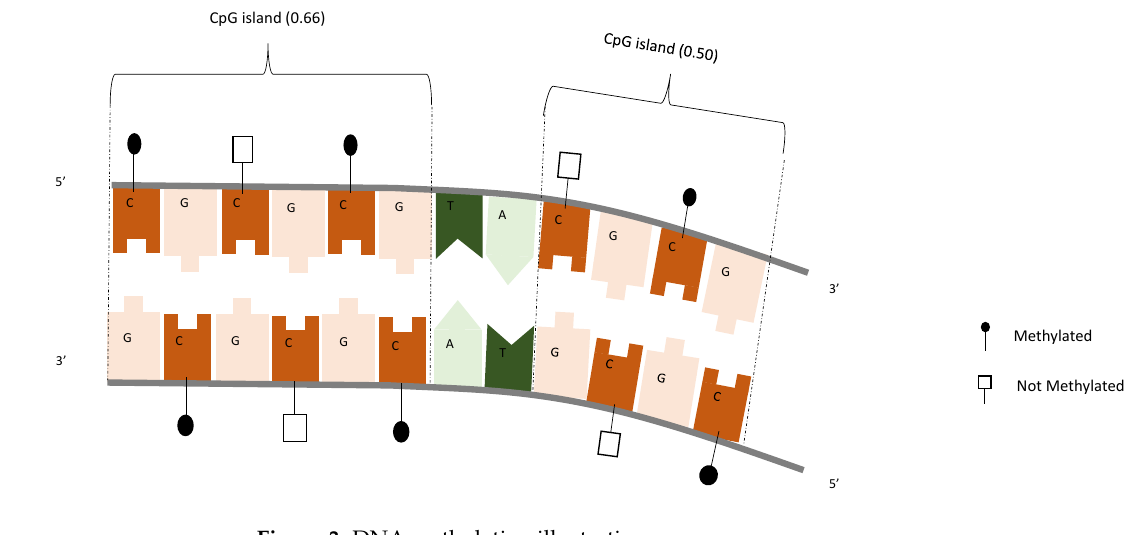
Figure 3. DNA methylation